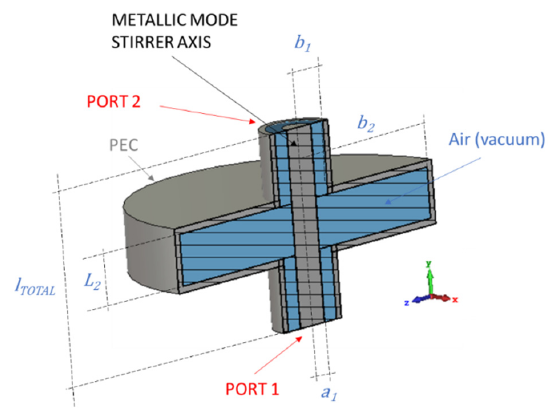
Figure 4. Simulated structure for the coaxial cavity bandstop resonator. l TOTAL = 6 cm, b 1 = 1 cm, and a 1 = 0.5 cm. The b 2 and L 2 values were fixed using parametric sweeps or using optimized values.